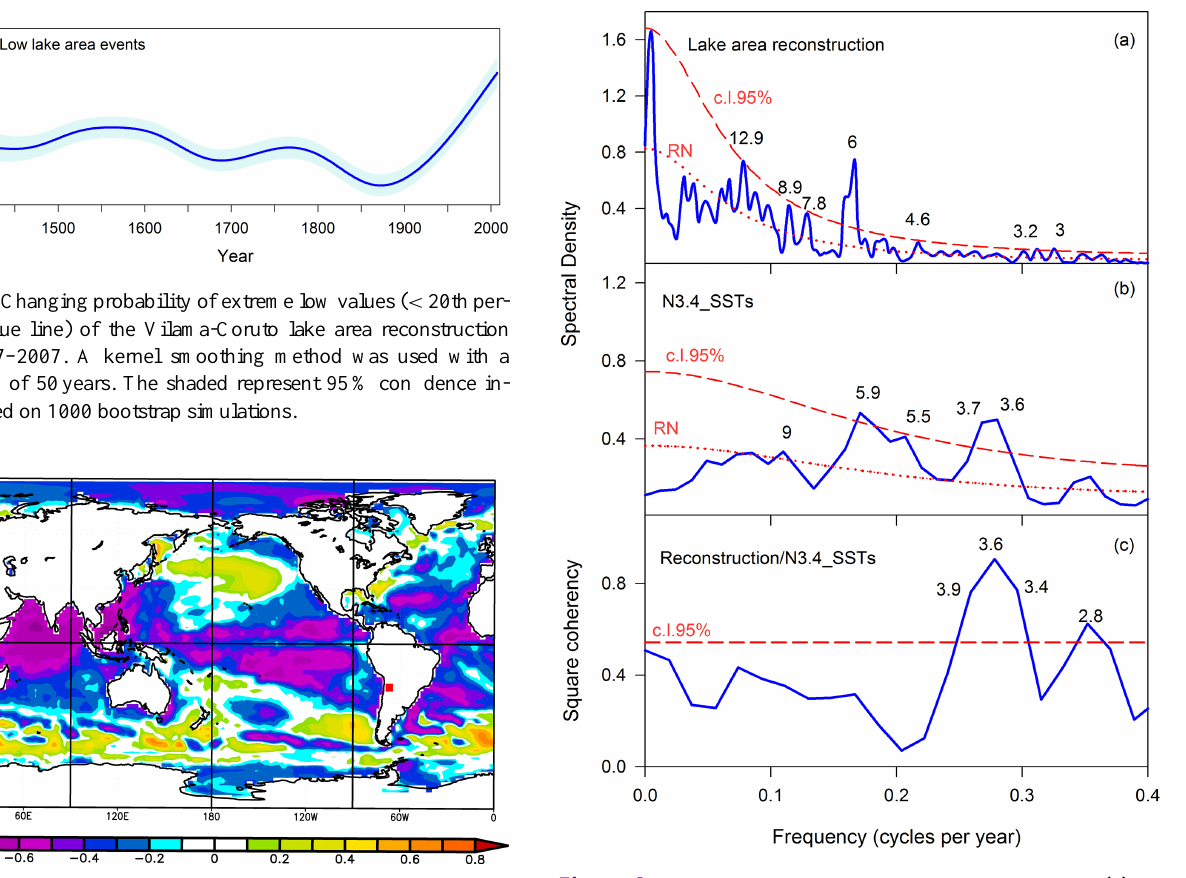
Figure 5. Spatial correlation patterns over the period 1948– 2006 between the 2.5 × 2.5 gridded monthly averaged January– December sea surface temperatures (SSTs) and the reconstructed January–December lake area for the Vilama-Coruto region. Spatial correlations were obtained from the National Oceanic and Atmo- pheric Administration website (http://www.esrl.noaa.gov/psd/data/ correlation/). The reconstructed lake area region is indicated by the red square.